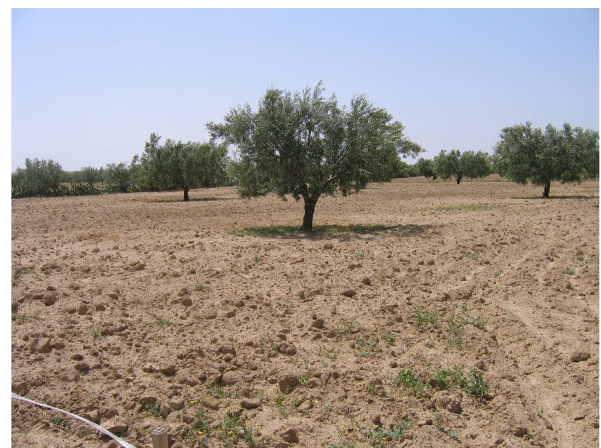
characterizing the canopy of an ecosystem. During